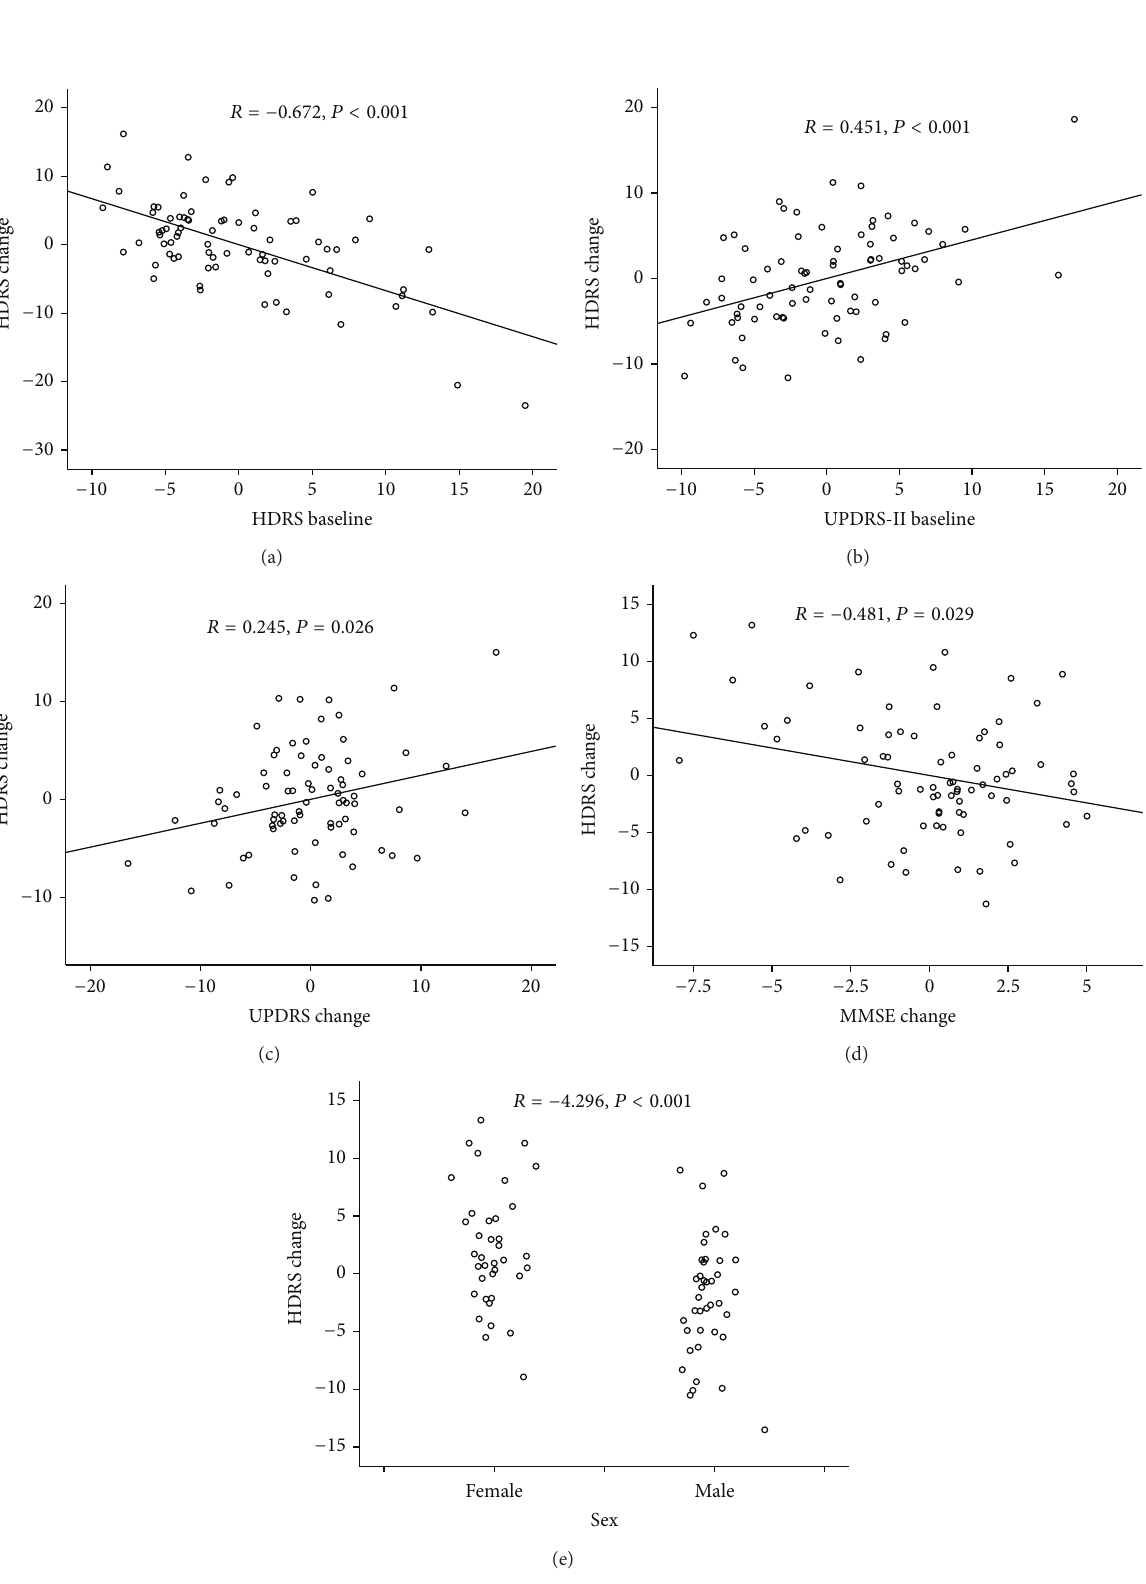
Figure 1: Clinical and demographic correlates of change in HDRS were shown in a linear regression equation. 𝑅 value represents coefficient. Abbreviations: PD: Parkinson’s disease; HDRS: Hamilton Depression Rating Scale; MMSE: Mini-Mental State Examination; UPDRS-II: The Unified Parkinson Disease Rating Scale for motor; UPDRS-III: The Unified Parkinson Disease Rating Scale for Activities of Daily